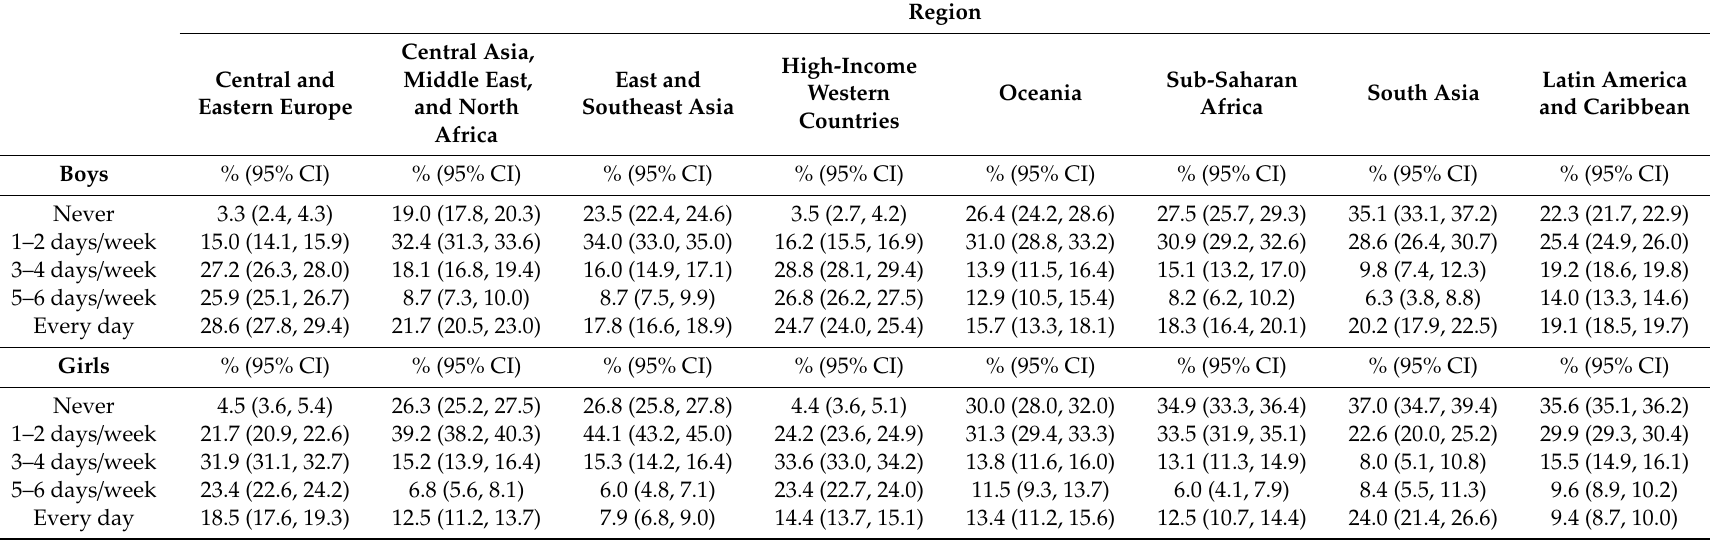
Table 4. Physical activity levels according to regions, stratified by sex.